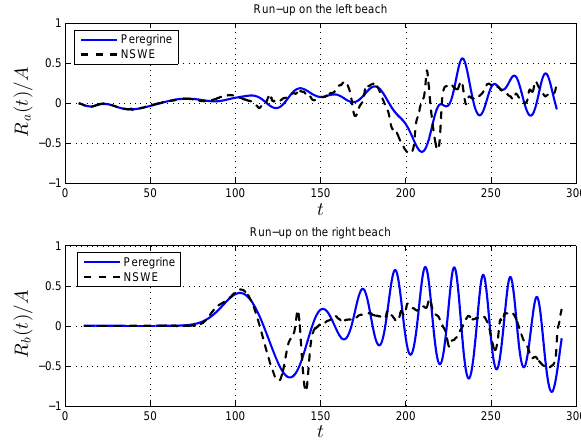
Fig. 13. Maximum and minimum of the surface excursion, and the horizontal velocity as a function of (non-dimensional) time.